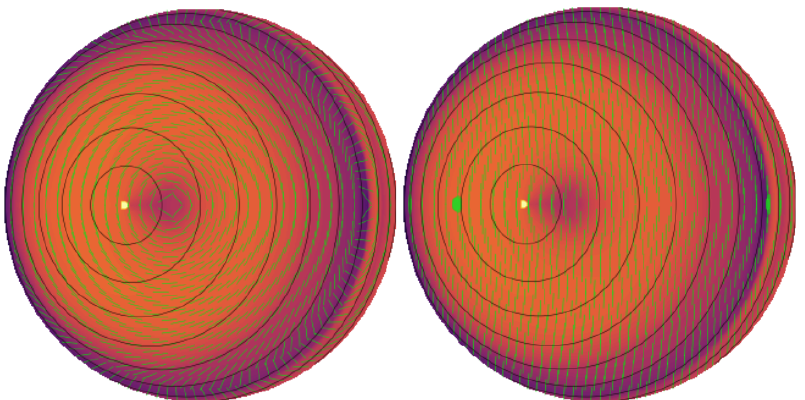
Figure 4. Surface polarization and emission map for the atmospheric model of 4U 0142+561; from [14].